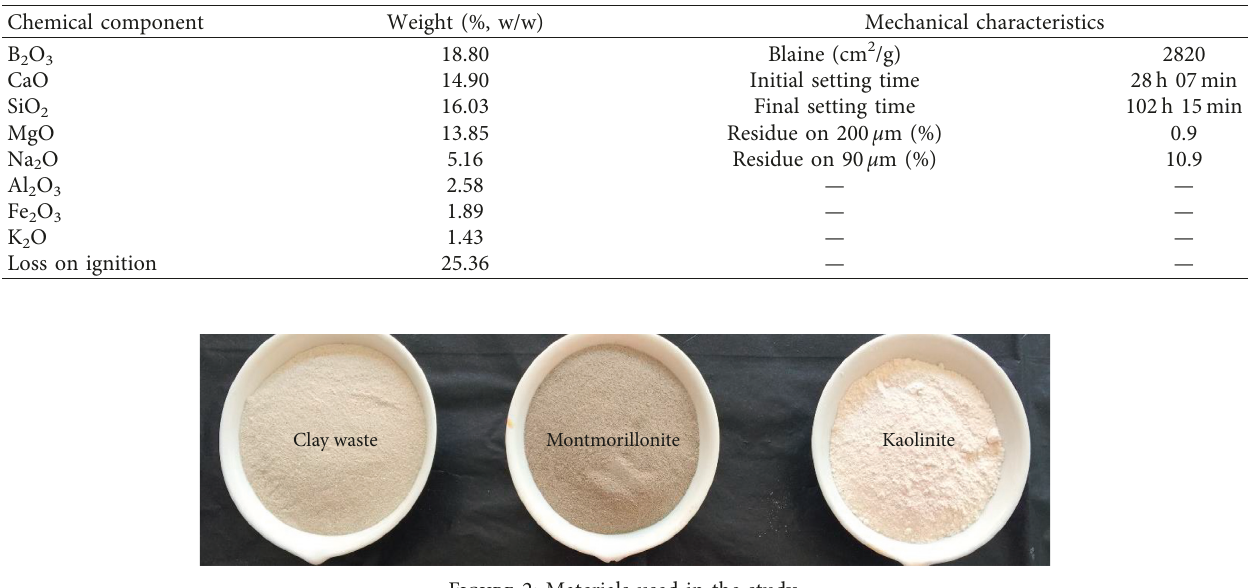
Table 1: Chemical components and physical characteristics of clay waste.